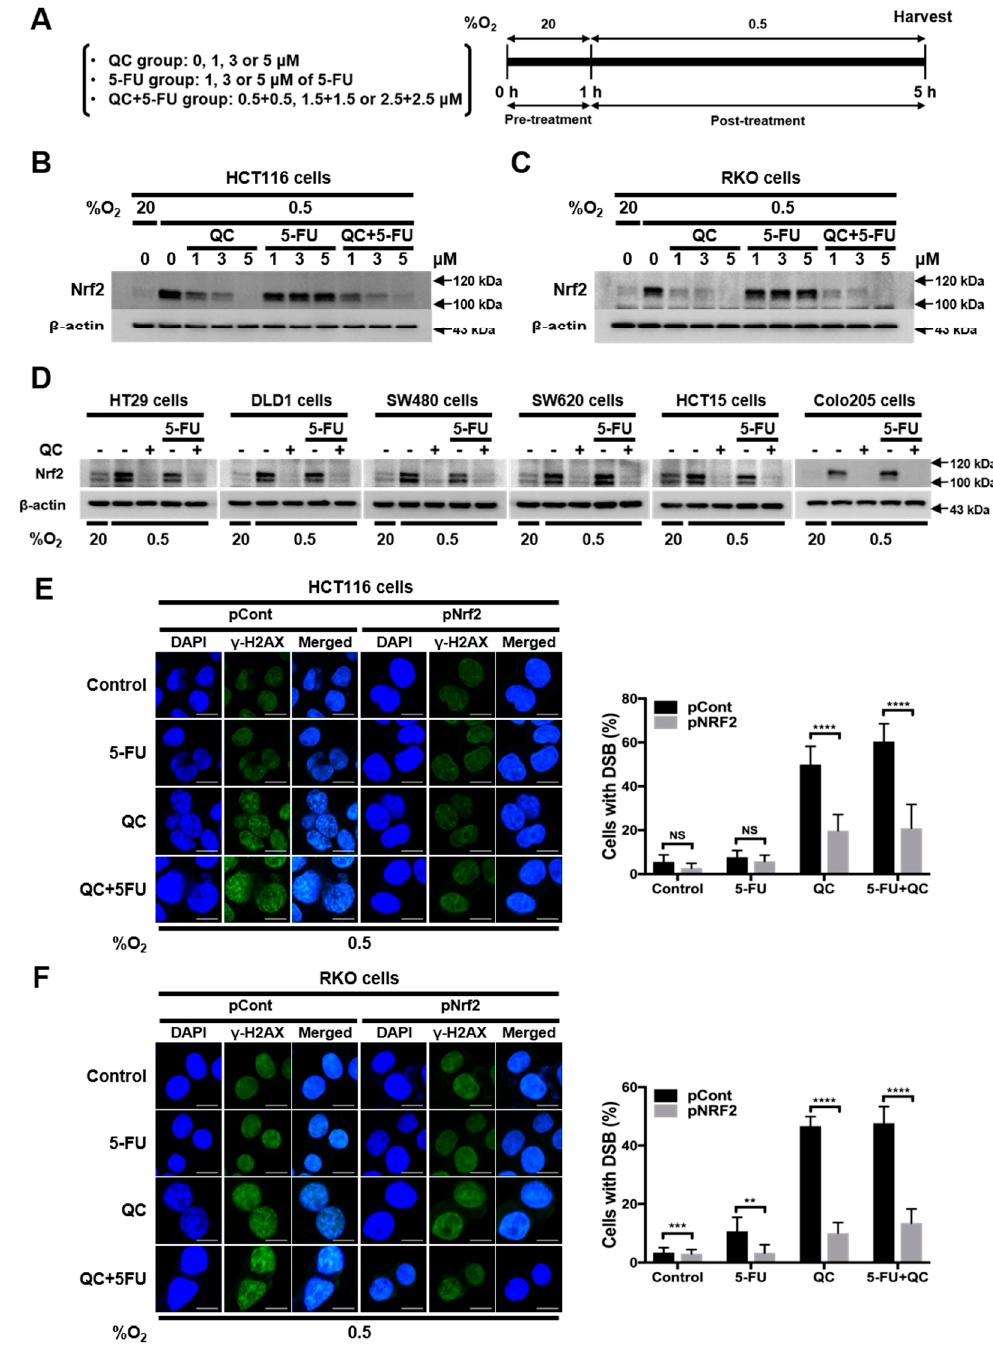
Figure 2. QC sensitizes CRC cells to 5-FU in hypoxia by inhibiting nuclear factor (erythroid-derived 2)-like 2 (Nrf2). ( A ) Scheme of the treatment and sampling procedure. ( B,C ) E ff ect of the QC / 5-FU combination on Nrf2 expression in HCT116 ( B ) and RKO ( C ) cells under hypoxic conditions. ( D ) E ff ect of the QC / 5-FU combination on Nrf2 expression in HT-29, DLD1, SW480, SW620, HCT15, and Colo205 cells under hypoxic conditions. Representative images of Nrf2 and β -actin were detected by immunoblot. Representative images of immunoblots for each protein were obtained using the same sample on di ff erent gels after a single experiment. ( E,F ) E ff ect of Nrf2 overexpression on DNA damage induced in HCT116 ( E ) and RKO ( F ) cells by the QC / 5-FU combination under hypoxic conditions. γ -H2AX (green) staining in HCT116 ( E ) and RKO ( F ) cells following treatment (left), and the relative percentage of foci-positive cells (right). Data are presented as means ± SD (** p < 0.01, *** p < 0.001, **** p < 0.0001 by ANOVA). “NS” indicates not significant ( p >